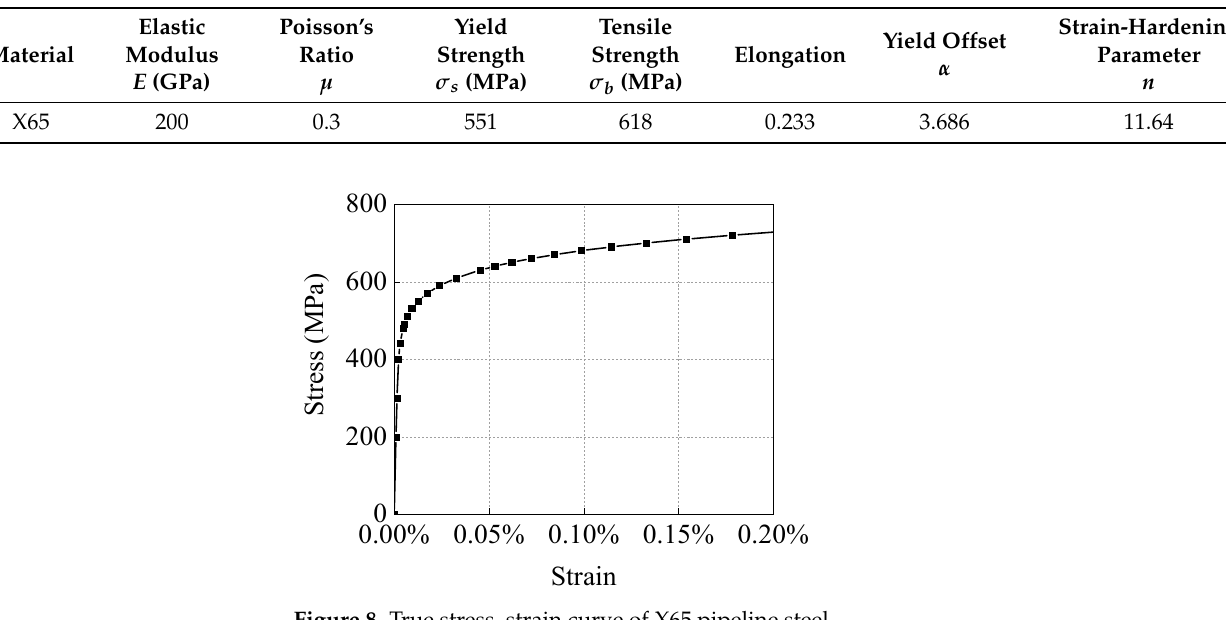
Figure 8. True stress–strain curve of X65 pipeline steel.